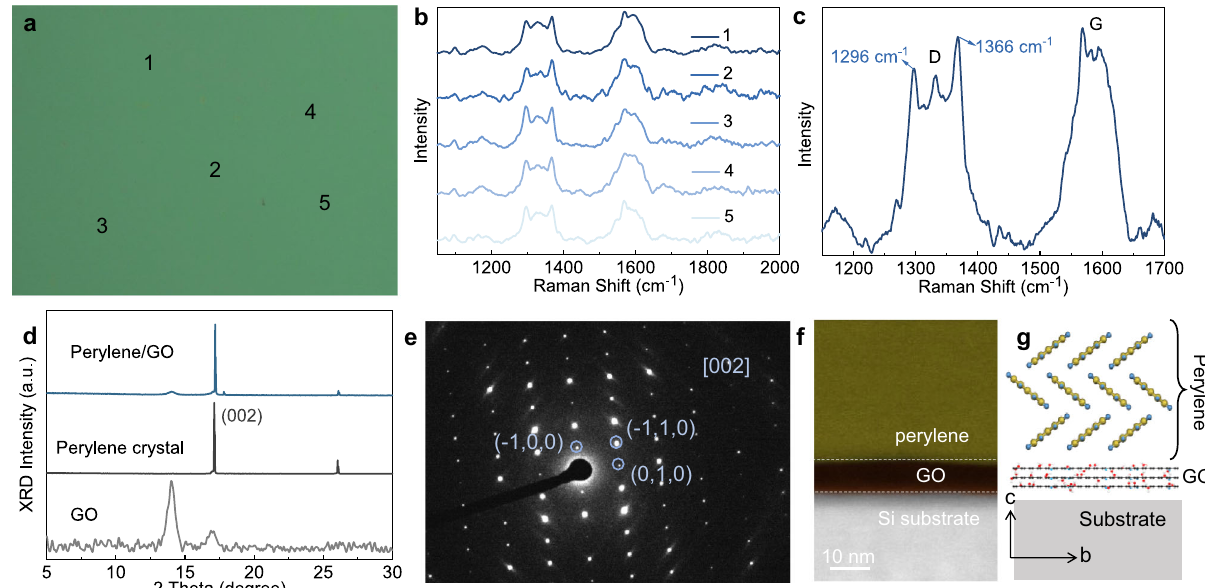
Fig. 2 | Structural characterization of the perylene/GO heterobilayer. a Optical image of the heterostructure fi lm transferred onto a 300-nm SiO 2 /Si wafer. b Raman spectra collected from regions labeled 1 – 5 in a . c Zoomed-in view of Ramanspectrawithfour-modeabsorption. d XRDspectratakenfromGO,perylene